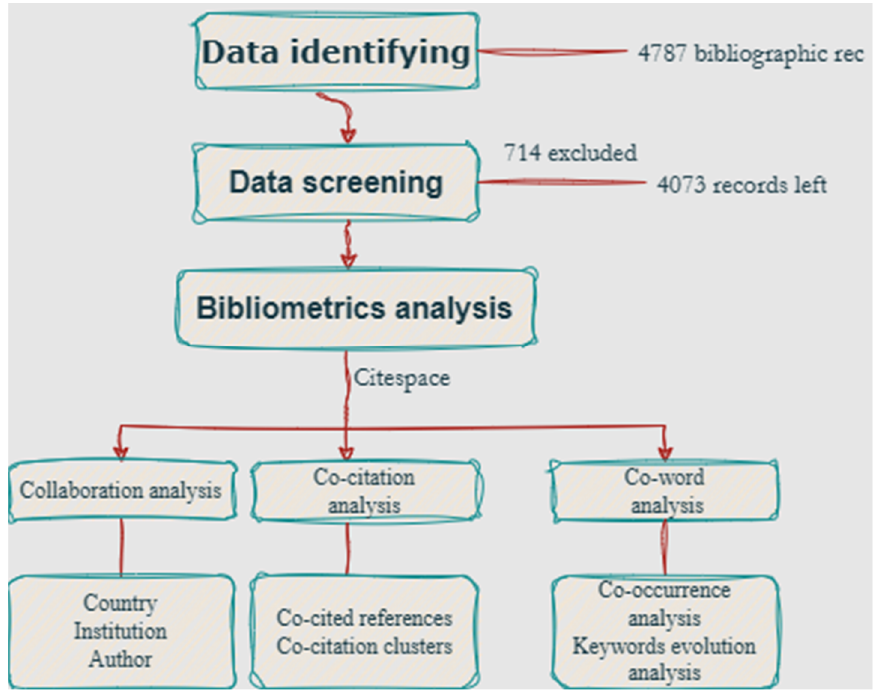
Figure 1. Research